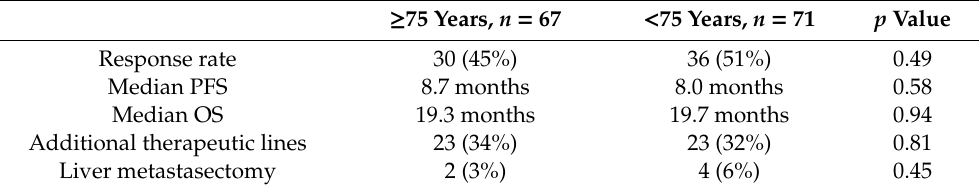
Table 3. Comparison of elderly patients ( ≥ 75 years) with younger patients ( < 75 years).